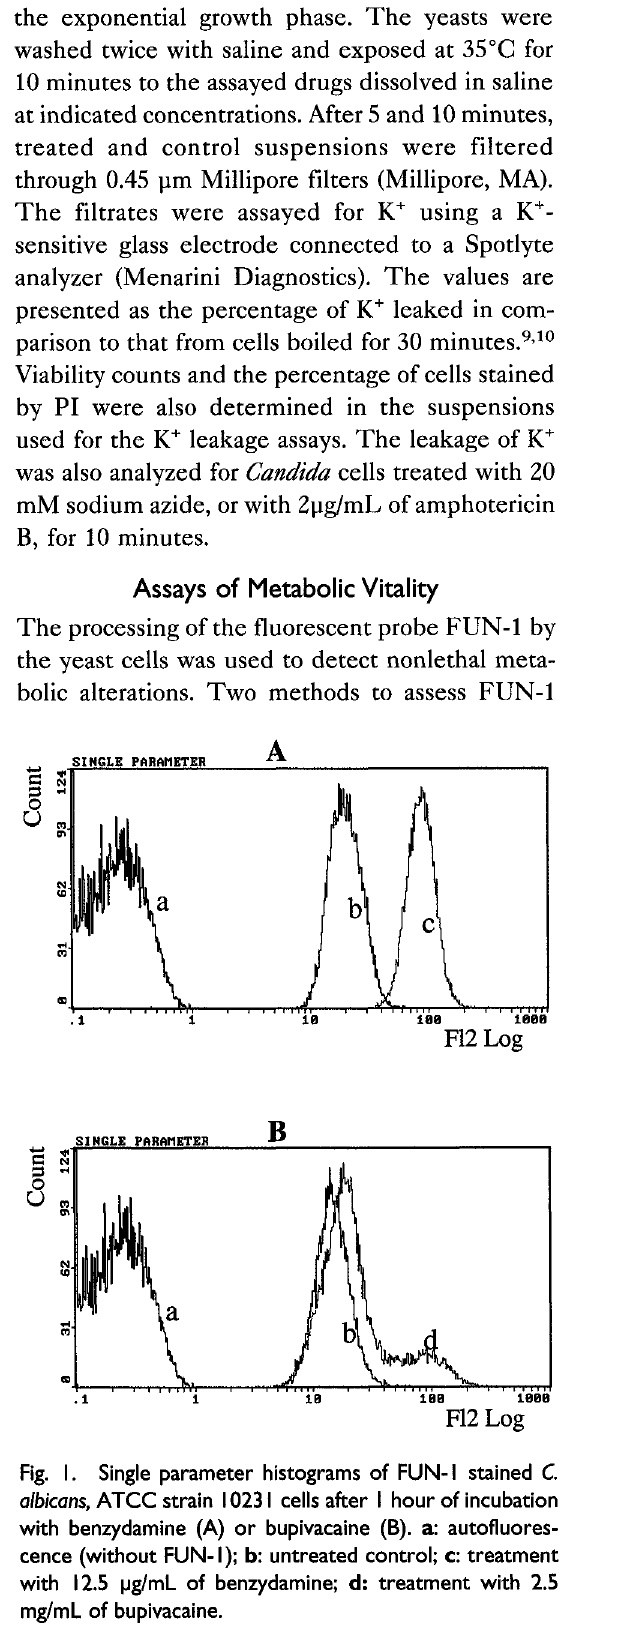
Fig. I. Single parameter histograms of FUN-I stained C. albicans, ATCC strain 10231 cells after hour of incubation with benzydamine (A) or bupivacaine (B). a: autofluores- cence (without FUN-I); b: untreated control; : treatment with 12.5 tsg/mL of benzydamine; d: treatment with 2.5 mg/mL of